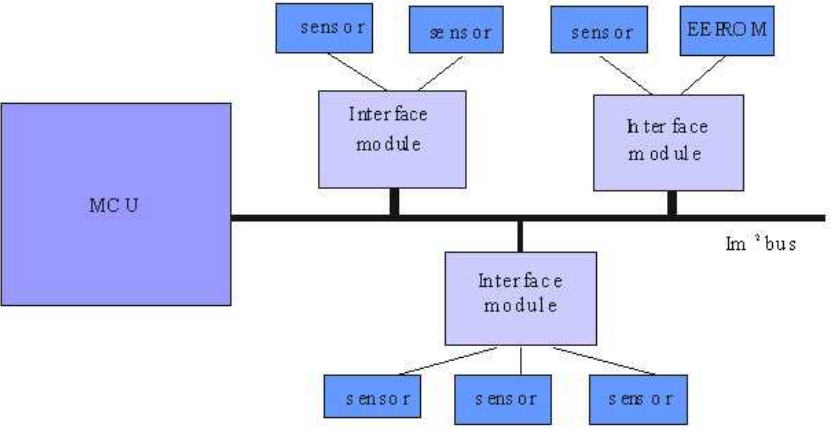
Figure 8 . Typical IM 2 bus